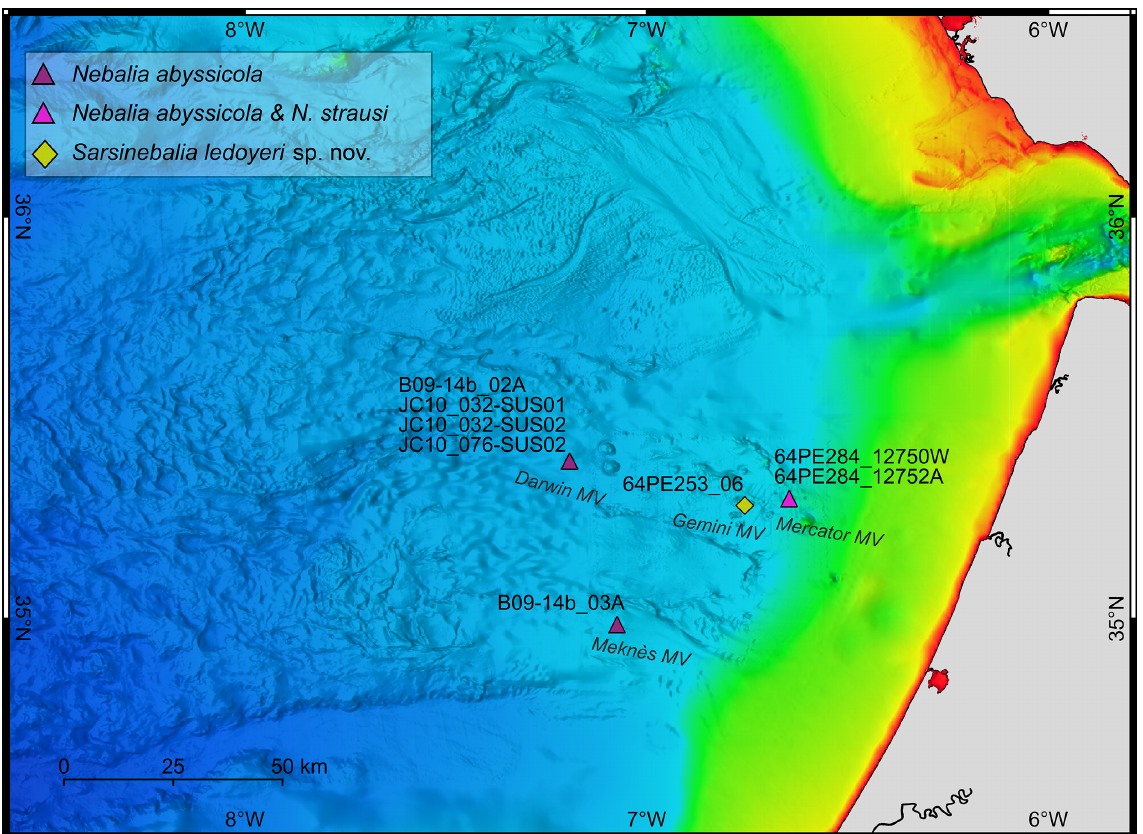
Fig. 1. Location of sampling sites in the mud volcanoes (Darwin, Gemini, Meknès, Mercator) at the Gulf of Cadiz within the Moroccan EEZ. Codes refer to samples obtained at each